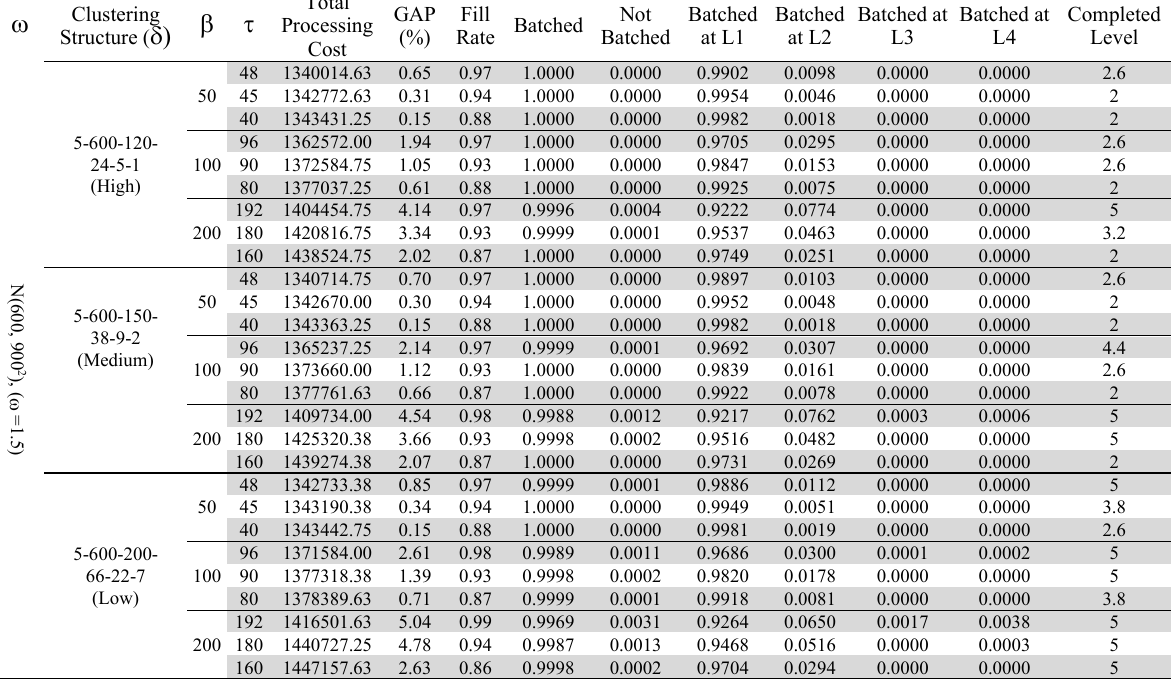
Results for demand scenario S-14 with 5-Level non-exclusive AHCS  Clustering Structure (  )